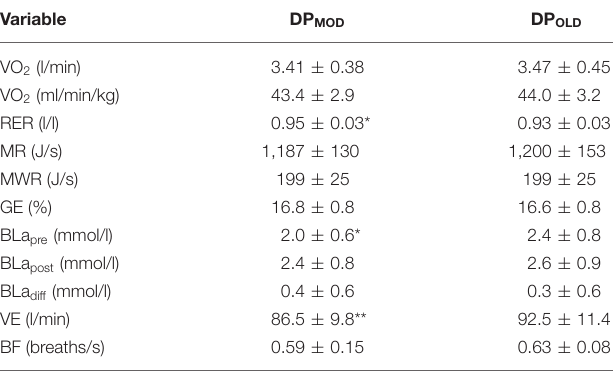
TABLE 2 | Test results for the physiological variables (mean ± standard deviation).